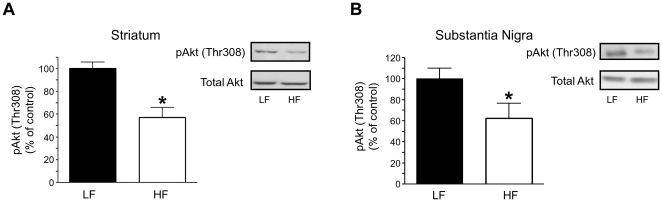
DIO induces a decrease in pAkt(Thr308) in the striatum and substantia nigra.Tissue from the striatum (A) and substania nigra (B) was analyzed by immunoblotting for levels of pAkt (Thr308) and total Akt. Data are expressed as a percent of LF control rats (LF, n = 6; HF, n = 7; *p<0.05 by Student t-test;). Data are represented as mean ± S.E.M.